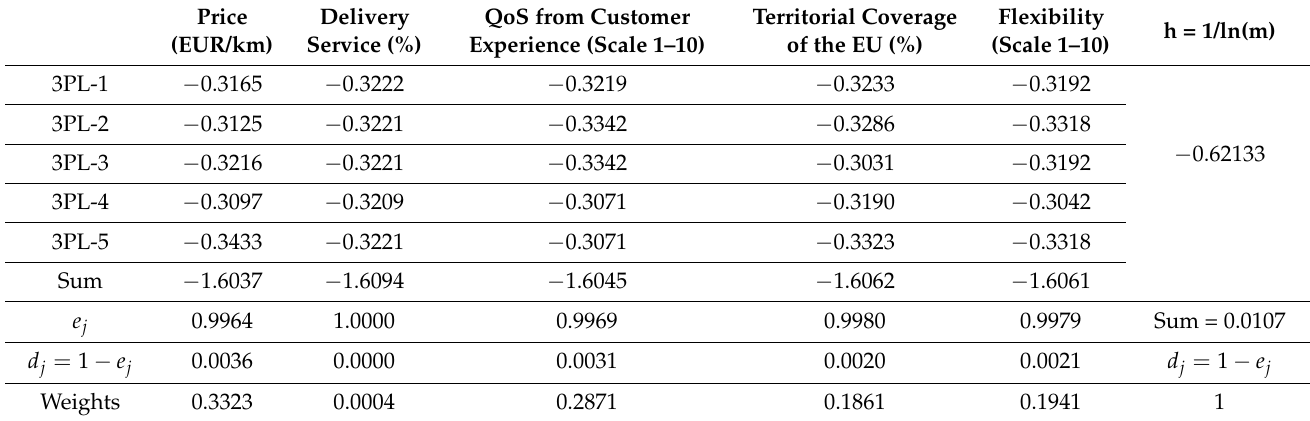
Table 5. Computed entropy value (h) and final weights (Source: Authors).